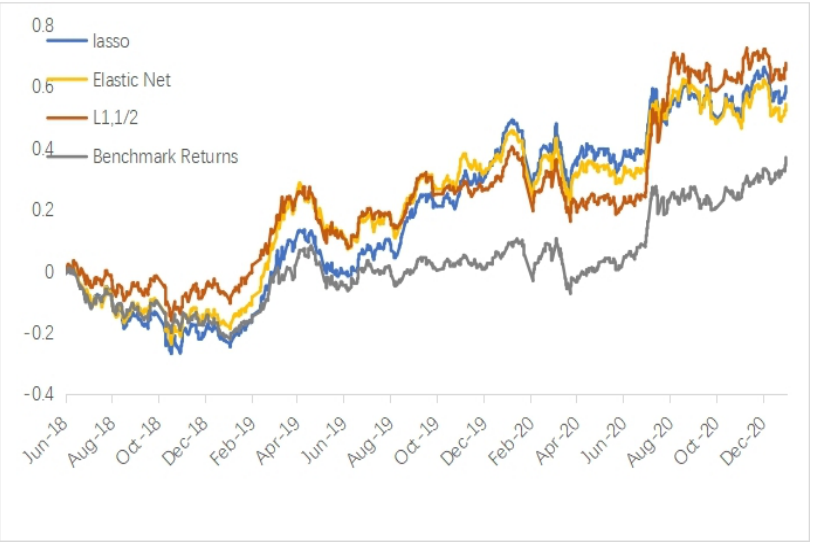
Figure 1. The cumulative yield